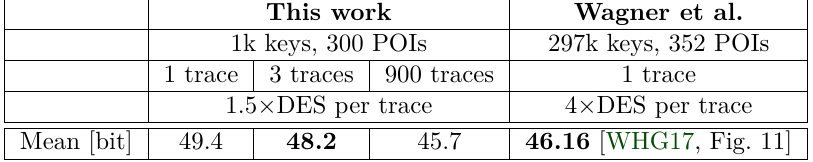
Table 1: Average security levels after attacking a varying numbers of traces per